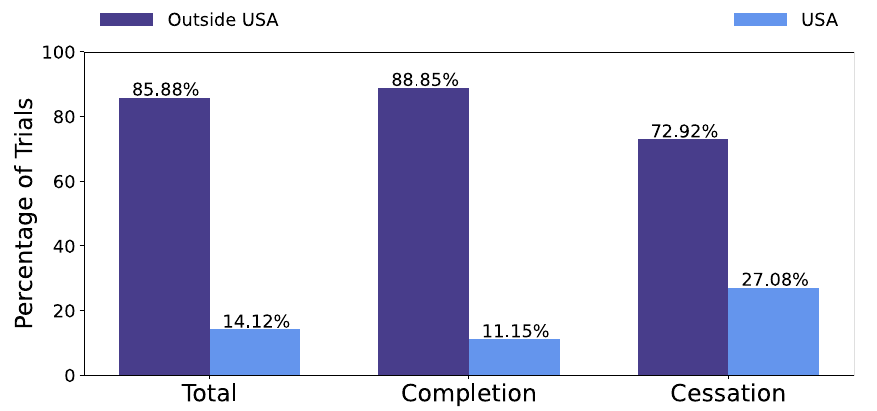
Fig 6. Distribution of trials that are outside or inside USA with respect to all trials, successful trials and unsuccessful